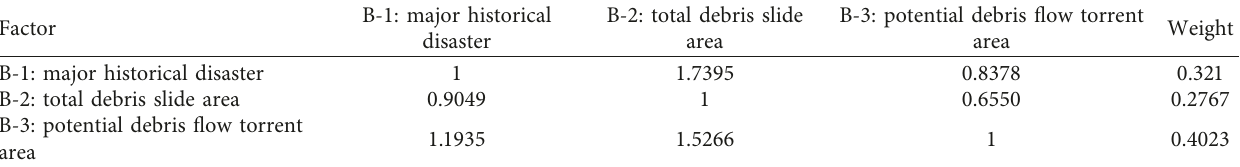
Table 7: Relative importance of factors for “B: hazard.”